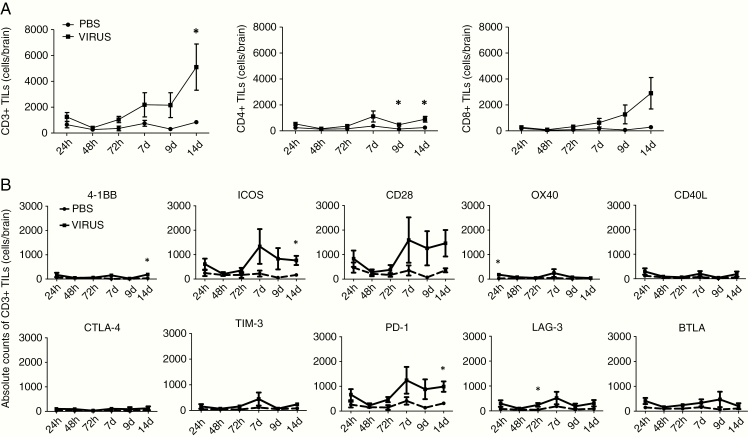
Delta24-RGD therapy significantly increases numbers of intratumoral ICOS+ and PD-1+ CD3+ T cells. C57BL/6J mice were inoculated i.c. with 5 × 104 GL261 cells and after 5 days treated i.c. with 2 × 107 pfu Delta24-RGD and control mice were treated with 10 µL PBS. Mice were sacrificed after 24 h, 48 h, 72 h, 7 days, 9 days, and 14 days post-therapy and cells were processed for flow cytometry (n = 3–5 mice/time-point/group). (A) Delta24-RGD significantly increases intratumoral CD3+ T cells on day 14 after therapy, reflecting an increase in CD8+ T cells. (B) Absolute numbers of CD3+ T cells were assessed and the expression of each co-signaling receptor within CD3+ T cells is analyzed. On day 14 after Delta24-RGD therapy, there was an increase in ICOS+ and PD-1+ TILs. P values were calculated with the Student t-test, *P < .05.